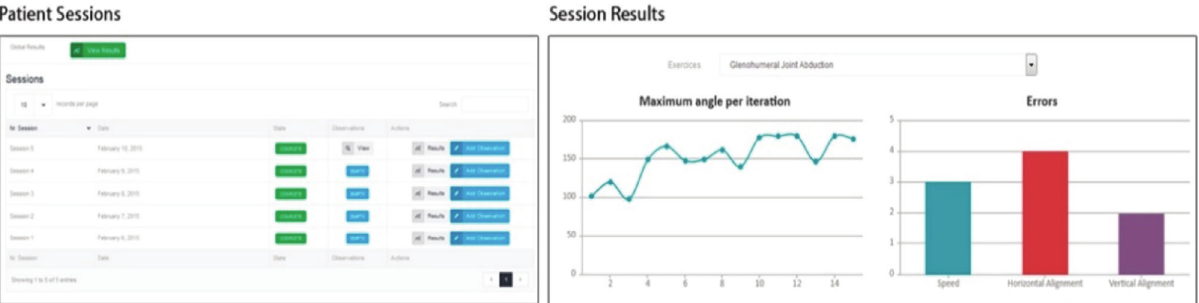
Figure 11: Specific results of a physical therapy session.